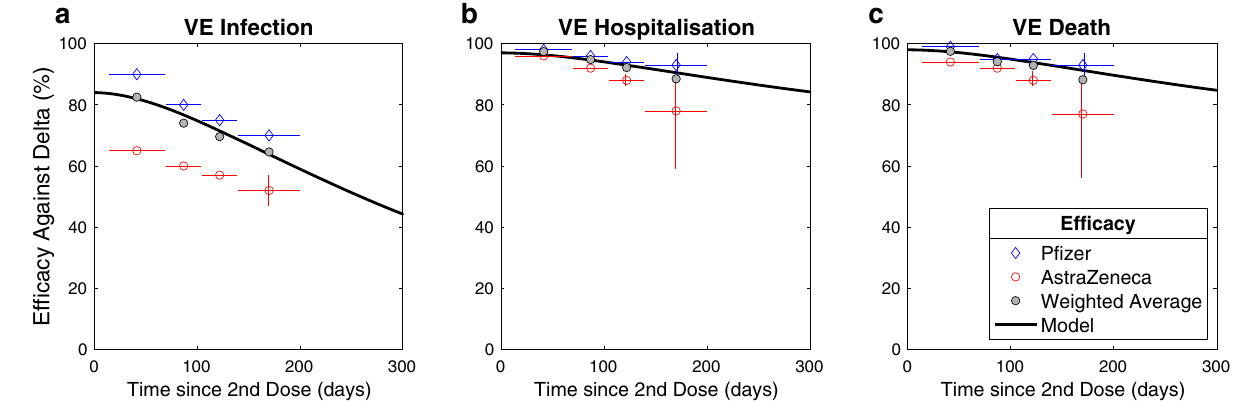
Fig. 4 | Comparison between model assumptions and estimates of vaccine ef fi cacyagainsttheDeltavariantforinfection(a),hospitalisation(b)anddeath (c). DataaretakenfromUKHSAestimatesinDecember2021 33 ;dataisshownforthe P fi zervaccine(bluediamonds),AstraZenecavaccine(redcircles)andtheweighted